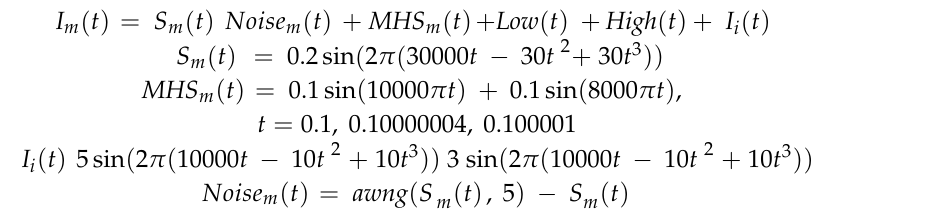
Figure 6. Experiment setup. FSM